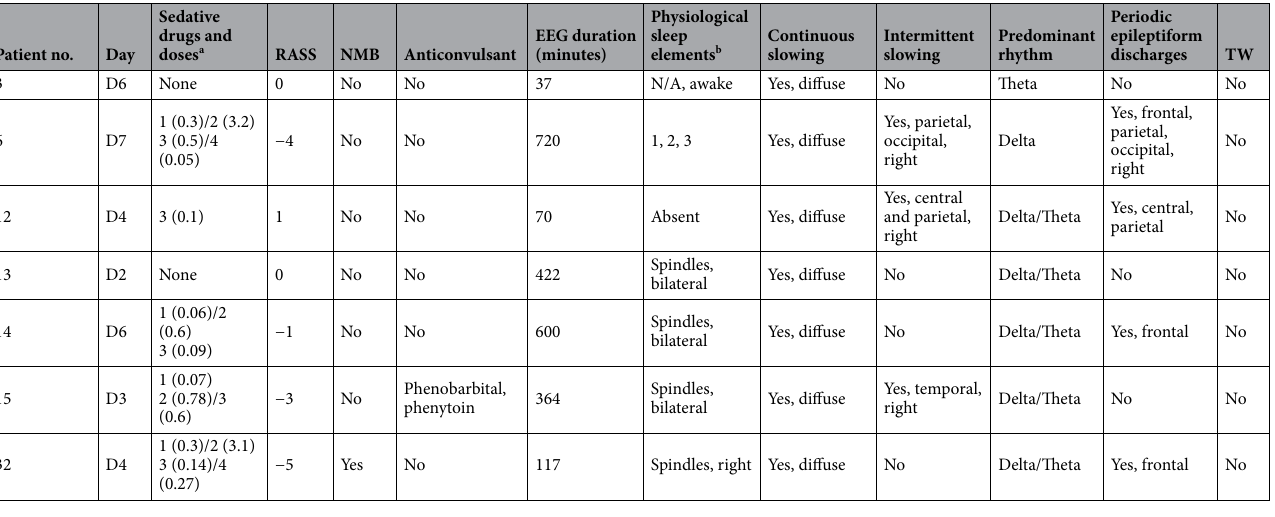
Table 3. Electroencephalographic characteristics considered presumptive of sepsis-associated encephalopathy in seven patients. RASS Richmond Agitation Sedation Scale, NMB neuromuscular